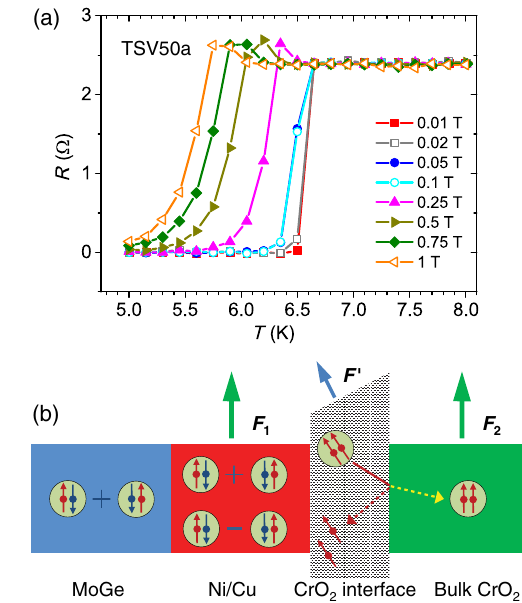
FIG. 5. Normal reflection of triplet Cooper pairs. (a) Resistive transitions of a spin valve device TSV50a, for different values of the in-plane field between 0 and 1 T. (b) Pictorial representation of the effect of an extra ferromagnetic layer F 0 between the mixer layer F 1 and the drainage layer F 2 on the generation of triplet pairs. The green arrows represent magnetization directions of F 1 ; 2 (in plane); the blue arrow indicates an interface layer F 0 with magnetization direction out of